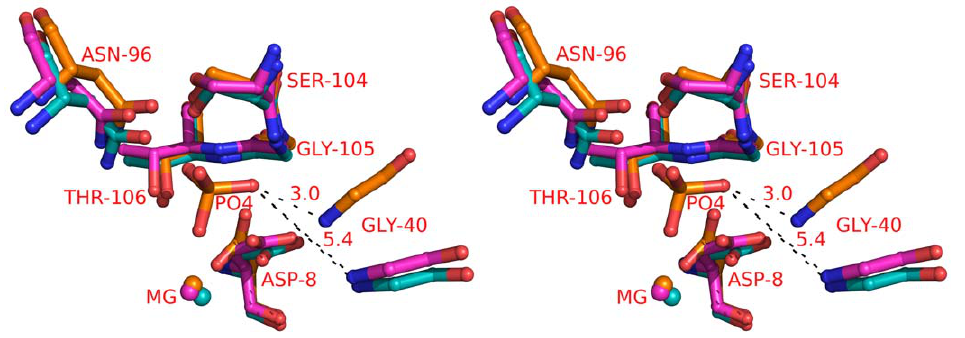
Figure 8. Stereo view of the active site residues of SurEs. Colour code: St SurE – orange, H234A – blue, D230A/H234A – magenta.